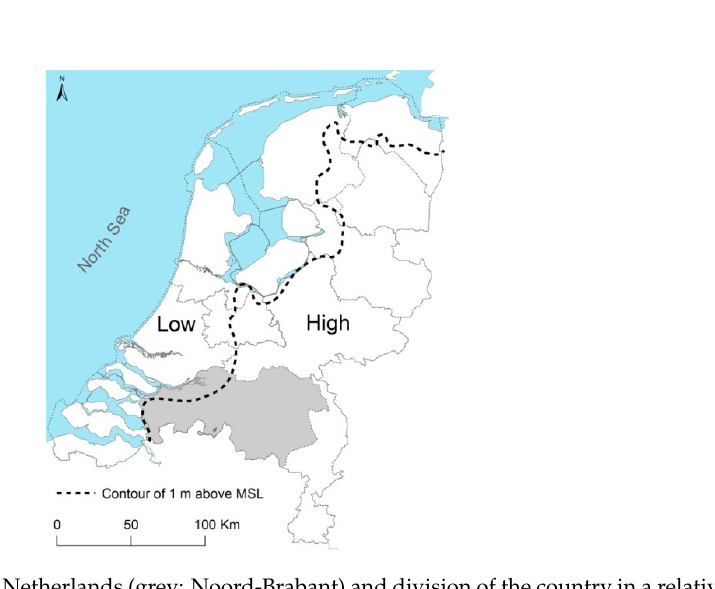
Figure 1. Provinces of the Netherlands (grey: Noord-Brabant) and division of the country in a relatively high part and a low part.